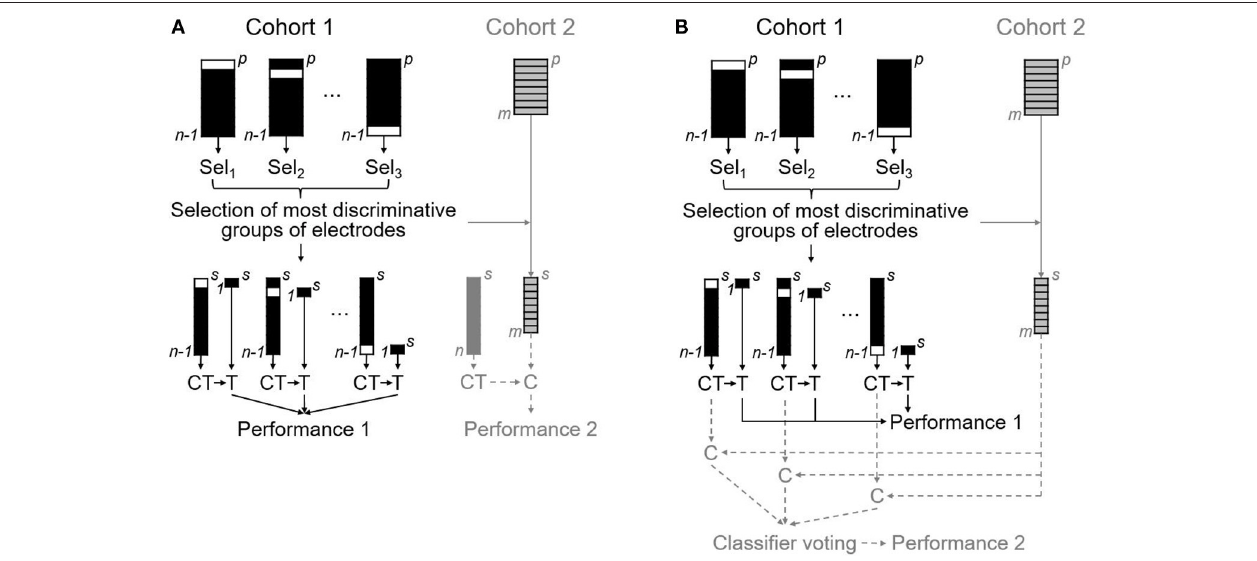
FIGURE 2 | The statistical model for prediction of VNS efficacy based on EEG analysis. Schematics representing the development of the statistical model on data from Cohort 1 outlining the selection of the most discriminative electrodes groups as well as classifier training (CT) and testing (T) performed in LOO manner (the black schematics); and two approaches taken for the validation procedure, whereby our statistical model was applied to an independent data-set from Cohort 2 (the gray schematics). Equivalent steps taken in each of the two validation approaches are visualized using solid lines, including the reduction of Cohort 2 by selecting the maximally discriminative electrodes identified in Cohort 1. The two approaches differ in the steps represented by dashed lines—i.e., the classification (C) of the reduced dataset using: (A) a single classifier trained on all n subjects from Cohort 1, and (B) voting of n classifiers trained on n -1 subsets of Cohort 1.